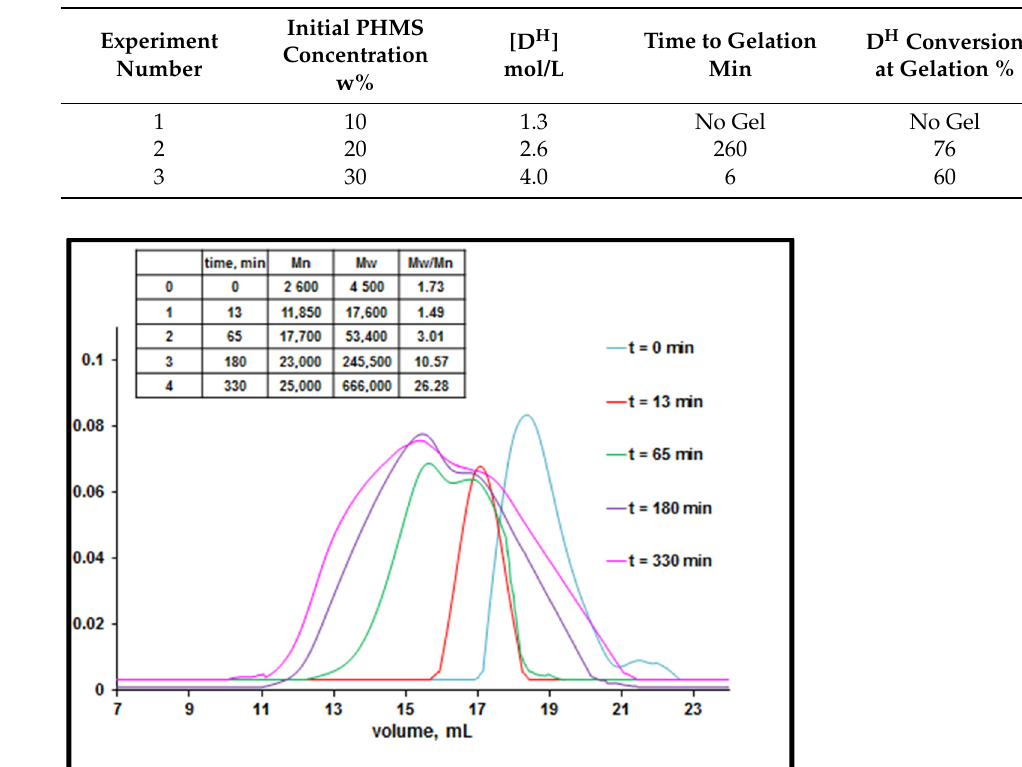
Table 2. Restructuring of PHMS in toluene solution at 30 ◦ C catalyzed by 1 × 10 − 2 mol/L B(C 6 F 5 ) 3 .